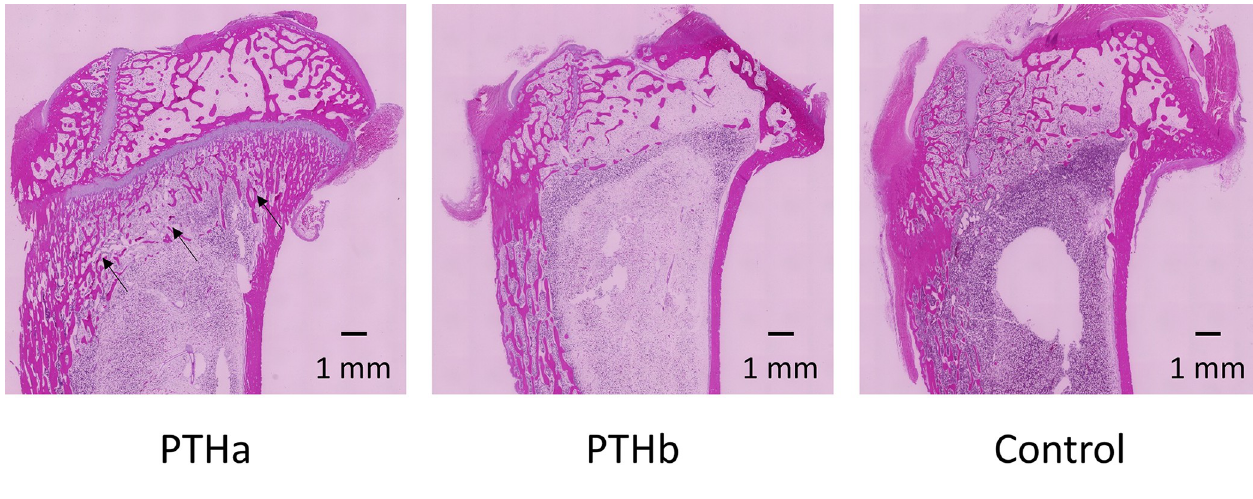
Fig 9. Histological evaluation of the tibiae. More trabecular bone structures were found at the epiphysis of tibiae in the PTHa group than in the PTHb and Control groups (black arrows).